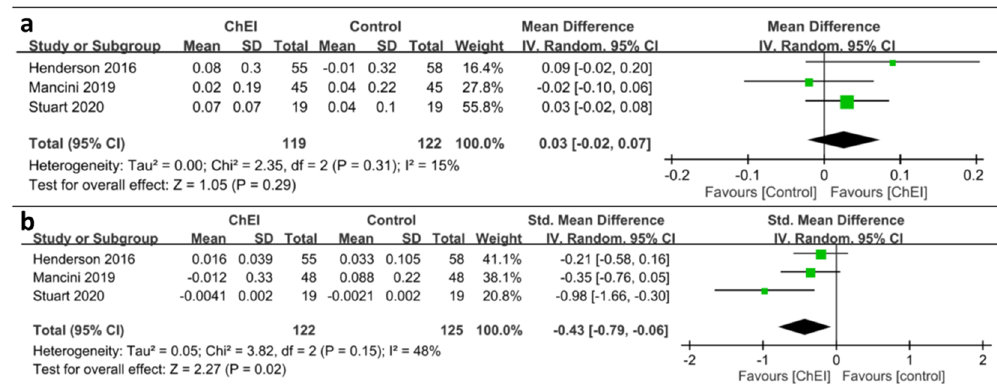
Fig. 2 Effect of cholinesterase inhibitors (ChEIs) on the gait speed and step/stride variability of patients with Parkinson disease (PD). a ChEIs did not signi fi cantly increase gait speed in patients with PD (Mean Difference [MD]: 0.03 m/s, 95% con fi dence interval [CI]: − 0.02 to